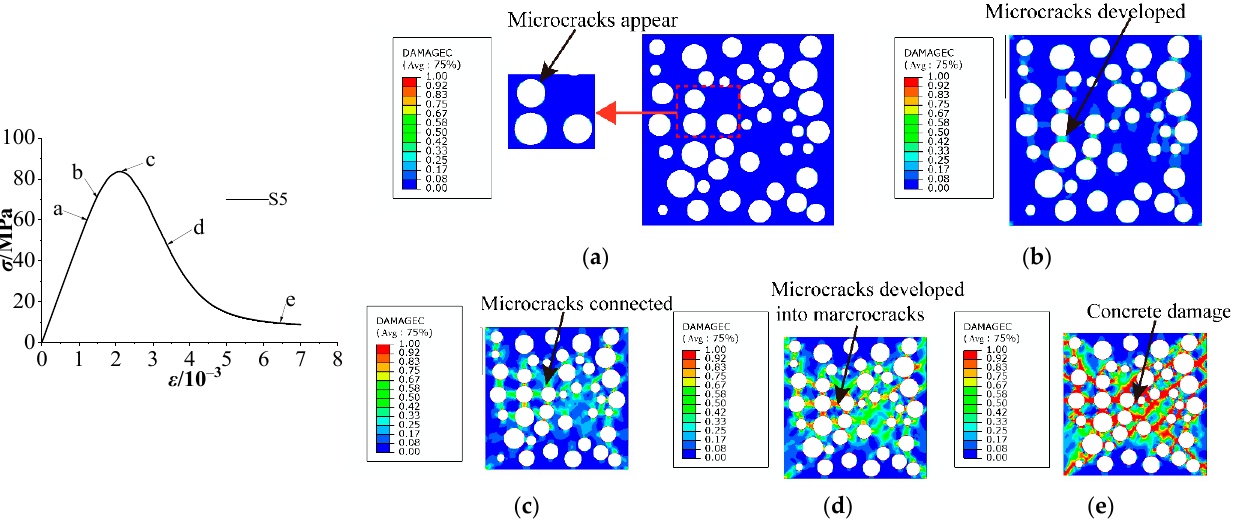
Figure 17. Cubic compression failure mode of concrete with 5% stone powder content (M2): ( a ) damage at point a, ( b ) damage at point b, ( c ) damage at point c, ( d ) damage at point d, and ( e ) damage at point e.